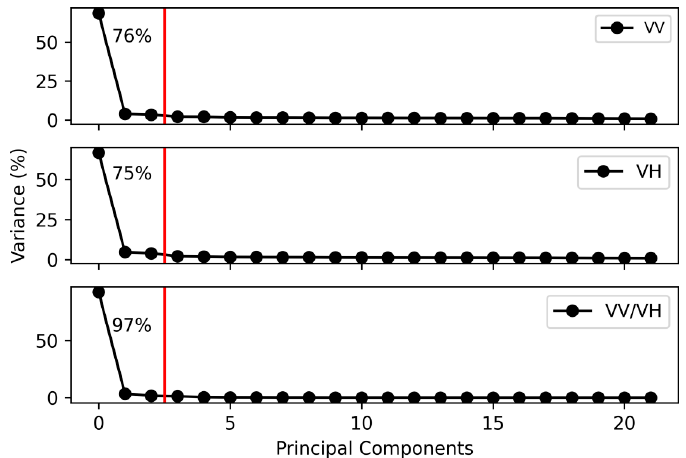
Figure 3. Schematic illustration of the experimental design.